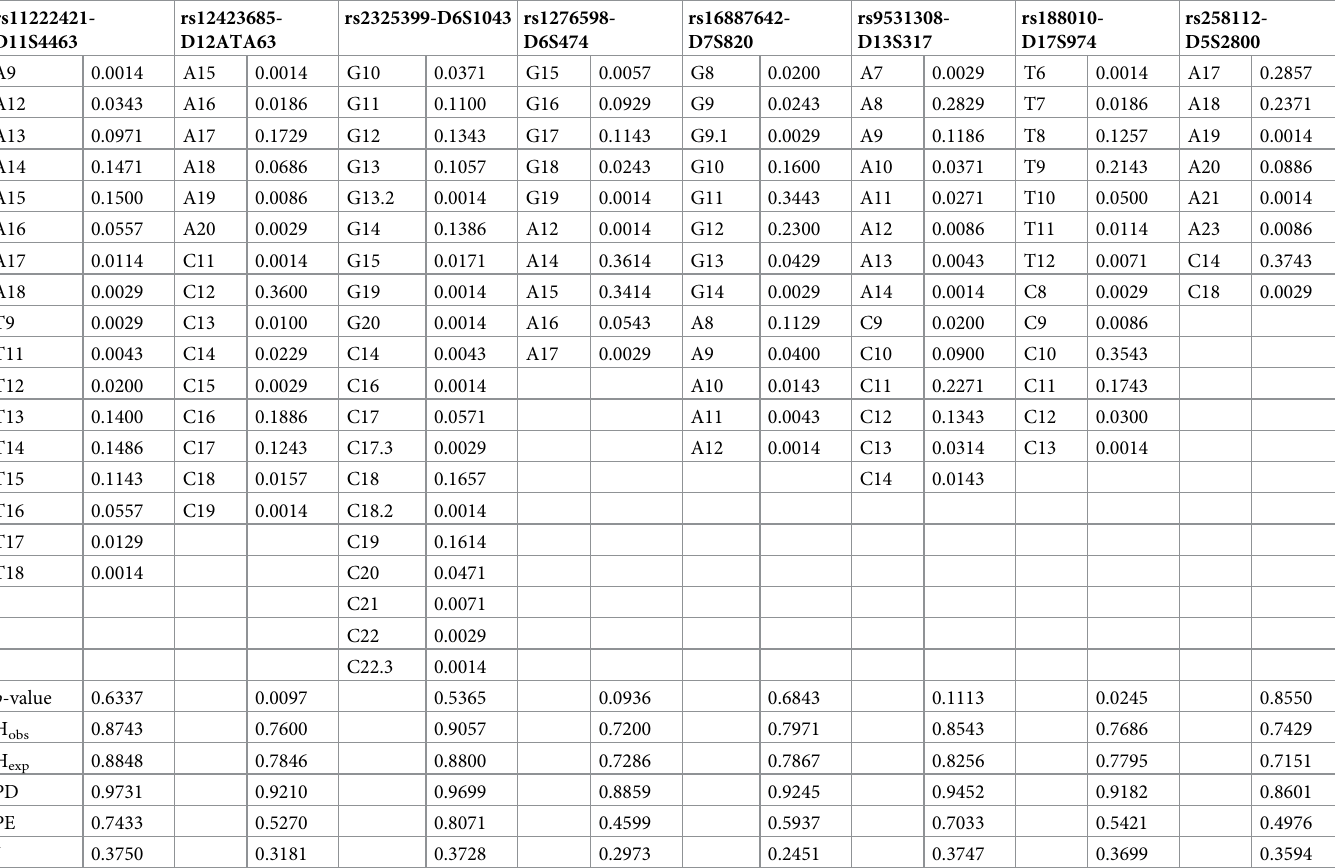
Table 2. Haplotype frequencies and forensic statistical parameters of the 8 SNP-STRs from Hubei Han population in China (n = 350). rs11222421- rs12423685- D11S4463